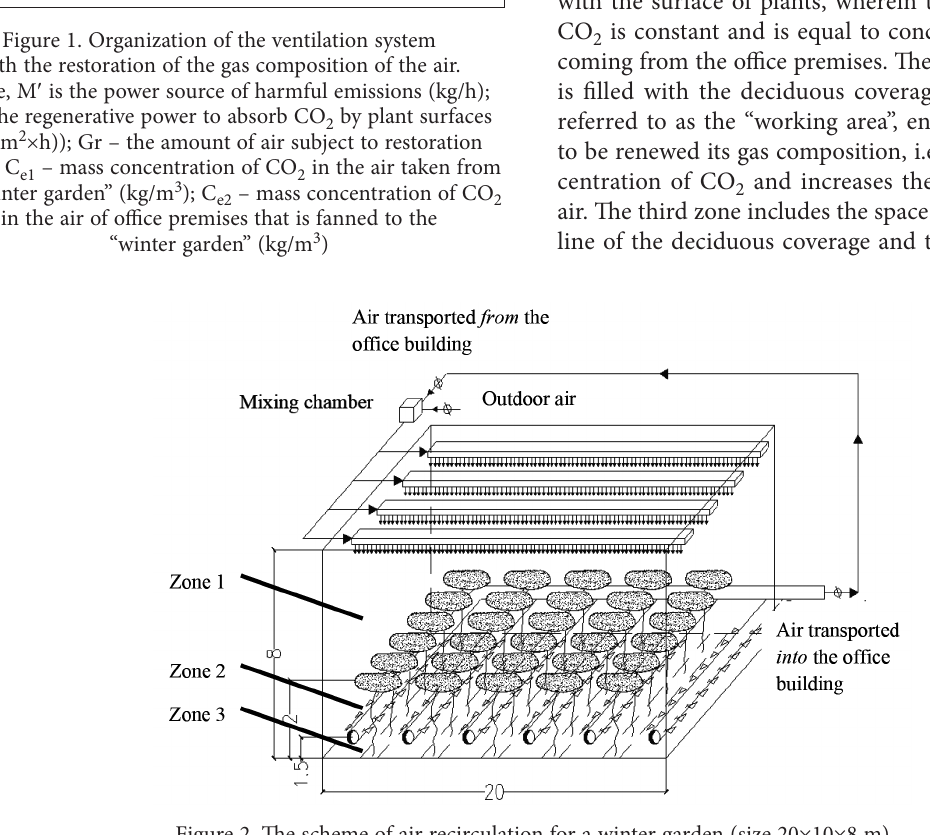
Figure 2. The scheme of air recirculation for a winter garden (size 20×10×8